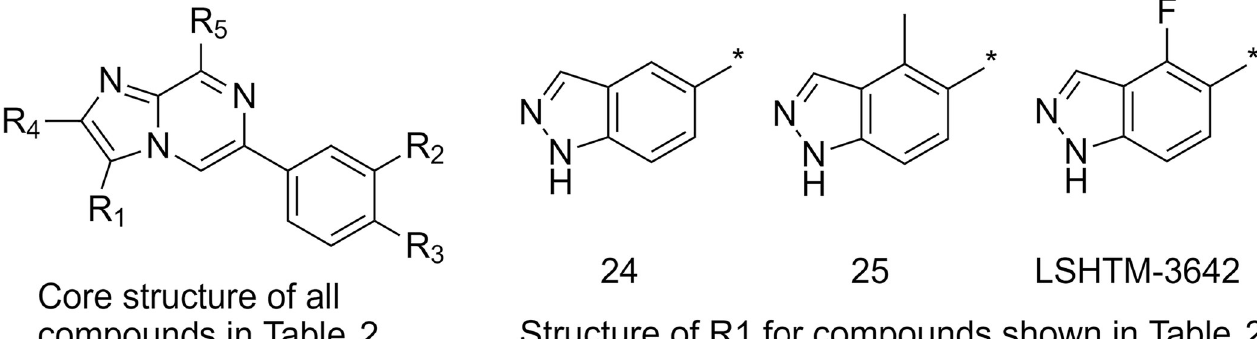
Fig 4. Guide to structures in Table 2.